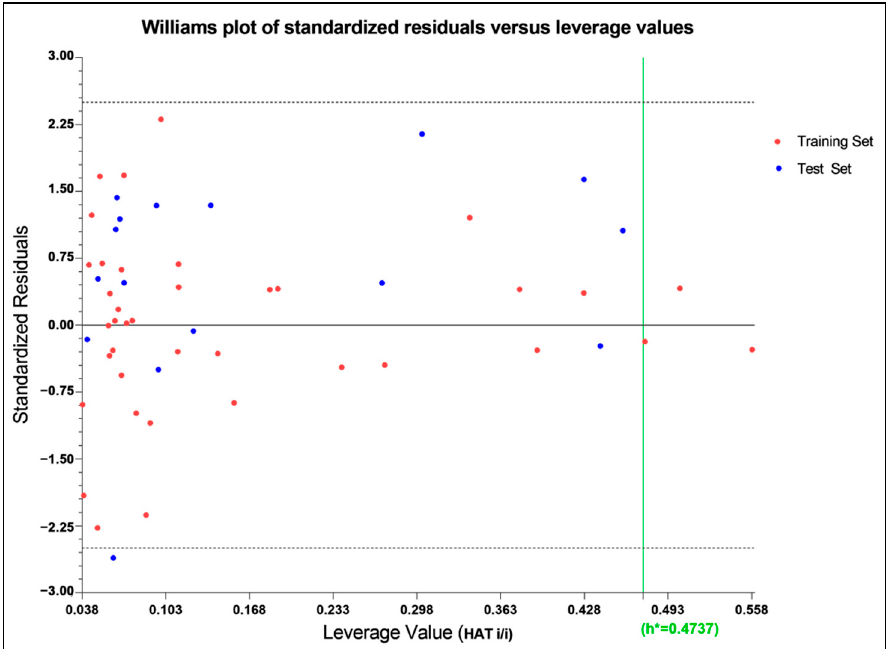
Figure 4. Willams plot to assess the applicability domain of the developed model. The threshold leverage value (h*) of the model is indicated by the green line which signified the majority of the molecules within the acceptable domain.